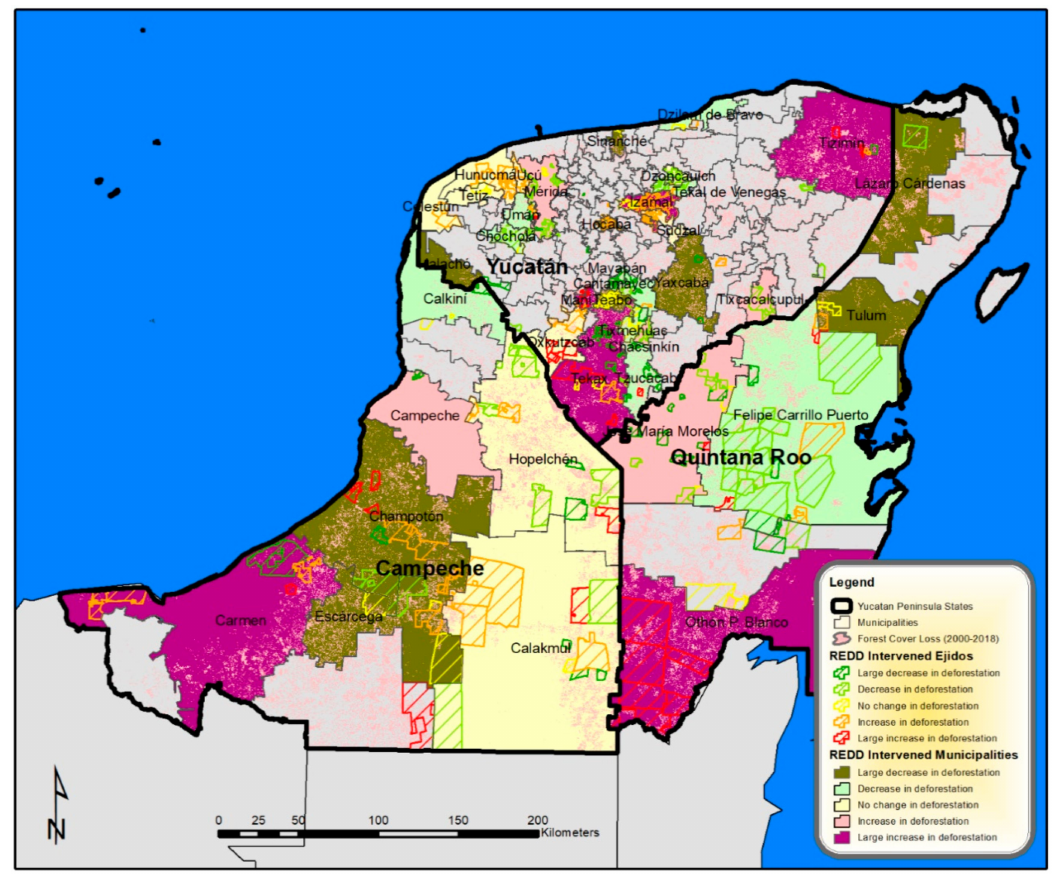
Figure 4. REDD + e ff ectiveness in reducing deforestation in selected intervened municipalities and intervened ejido territories on the Yucatan